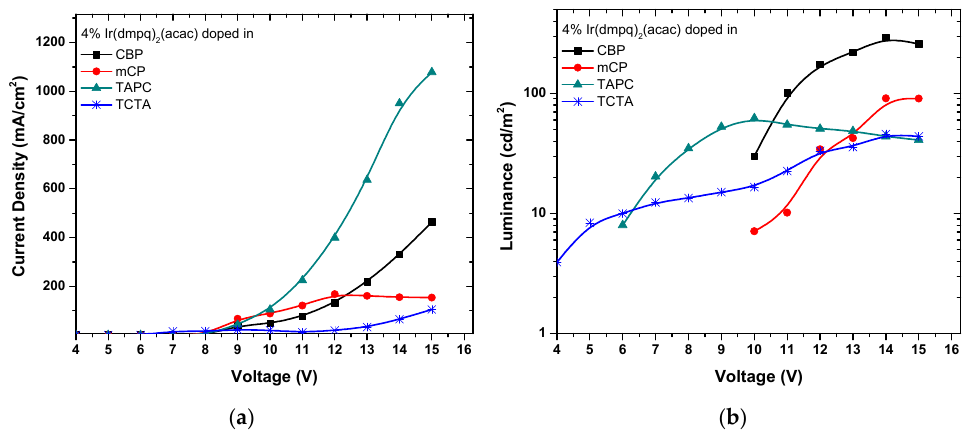
Figure 7. ( a ) The current density–voltage (J–V) characteristic curves and ( b ) logarithmic plot of luminance–voltage of the fabricated PhOLED devices.